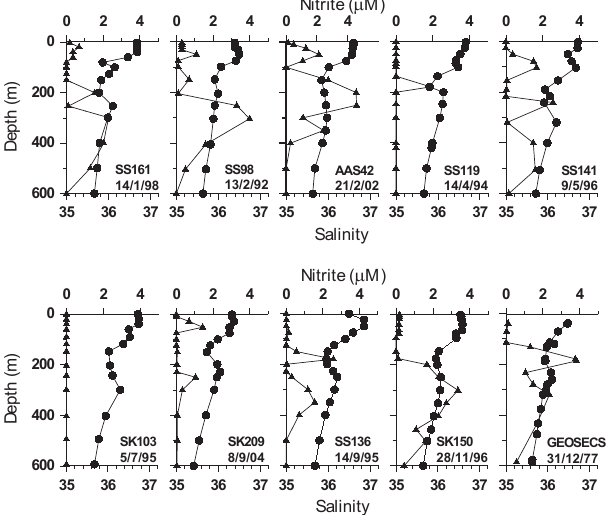
Fig. 6. Nitrite (triangles) and salinity (circles) to 600m depth at the site of GEOSECS sta. 416 of 1977, revisited between 1992 and 2004 (panels arranged by month of visit; diamond in Fig. 1 marks the location).